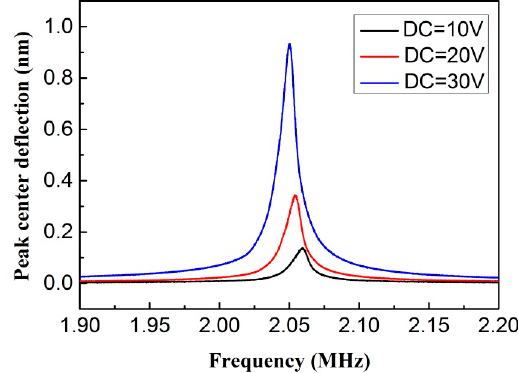
Figure 8. Peak center deflection as a function of frequency for CMUT at different DC levels with an AC voltage of 1 V pp in air.